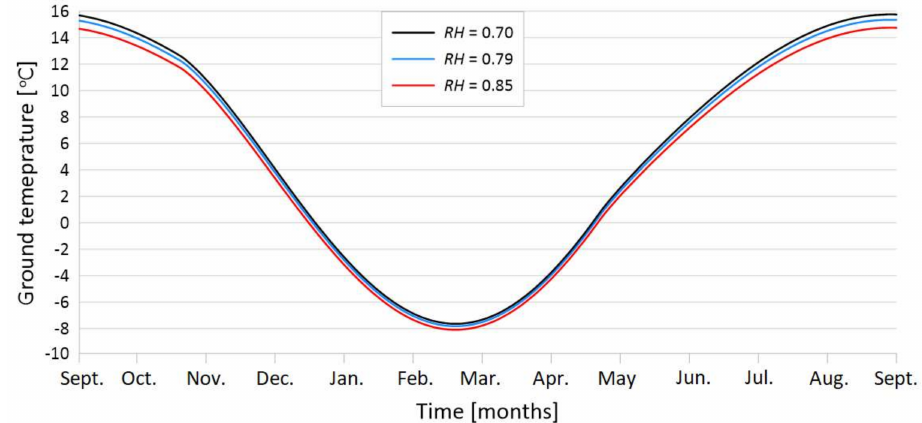
Figure 7. Influence of the relative humidity of ambient air on the ground temperature at the depth of the heat exchanger’s installation.